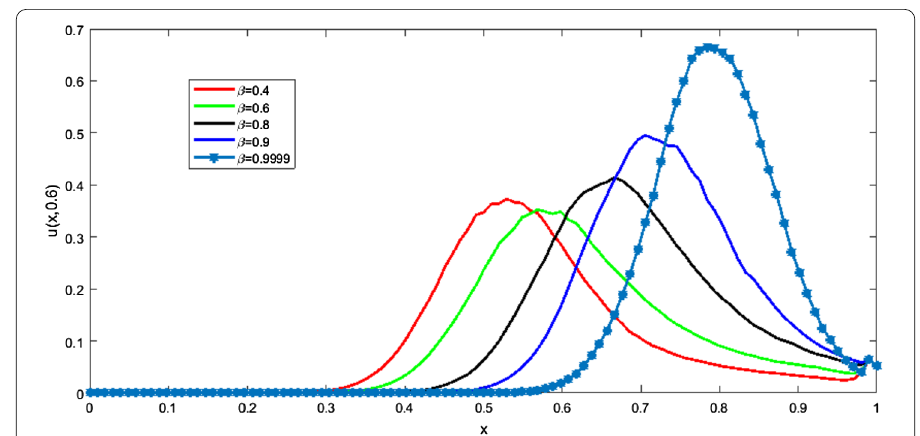
Figure 7 An approximate solution with α = 1.8 and β =